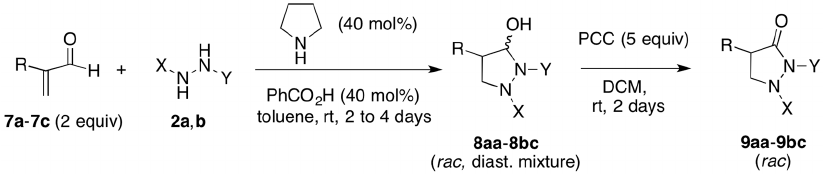
Table 1. Pyrrolidine-catalyzed synthesis of pyrazolidin-3-ols 8aa – 8bc from α -substituted enals 7a – 7c and hydrazines 2a and 2b , and oxidation to the corresponding pyrazolidin-3-ones 9aa – 9bc .